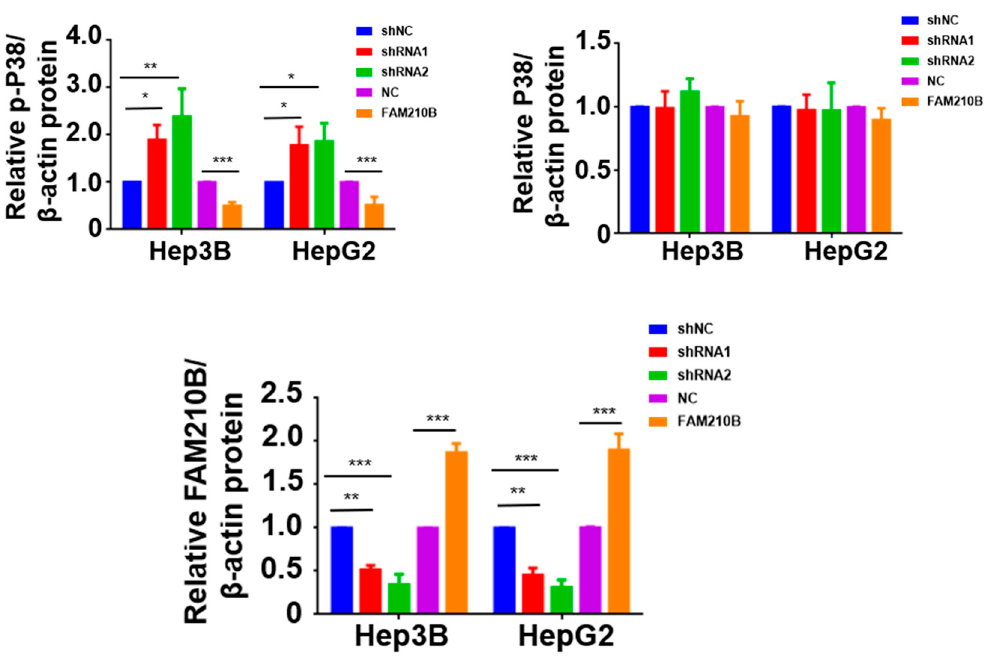
Figure 6. Loss of FAM210B activates MAPK signaling pathway and PI3K signaling pathway. Whole-cell lysates were generated from the HepG2 and Hep3B cells following transfection with FAM210B shRNA lentivirus or FAM210B overexpression lentivirus. Immunoblotting was examined with the indicated antibodies. The representative images and quantitative analysis were shown (n = 3). *: p < 0.05; **, p < 0.01; ***, p < 0.001.